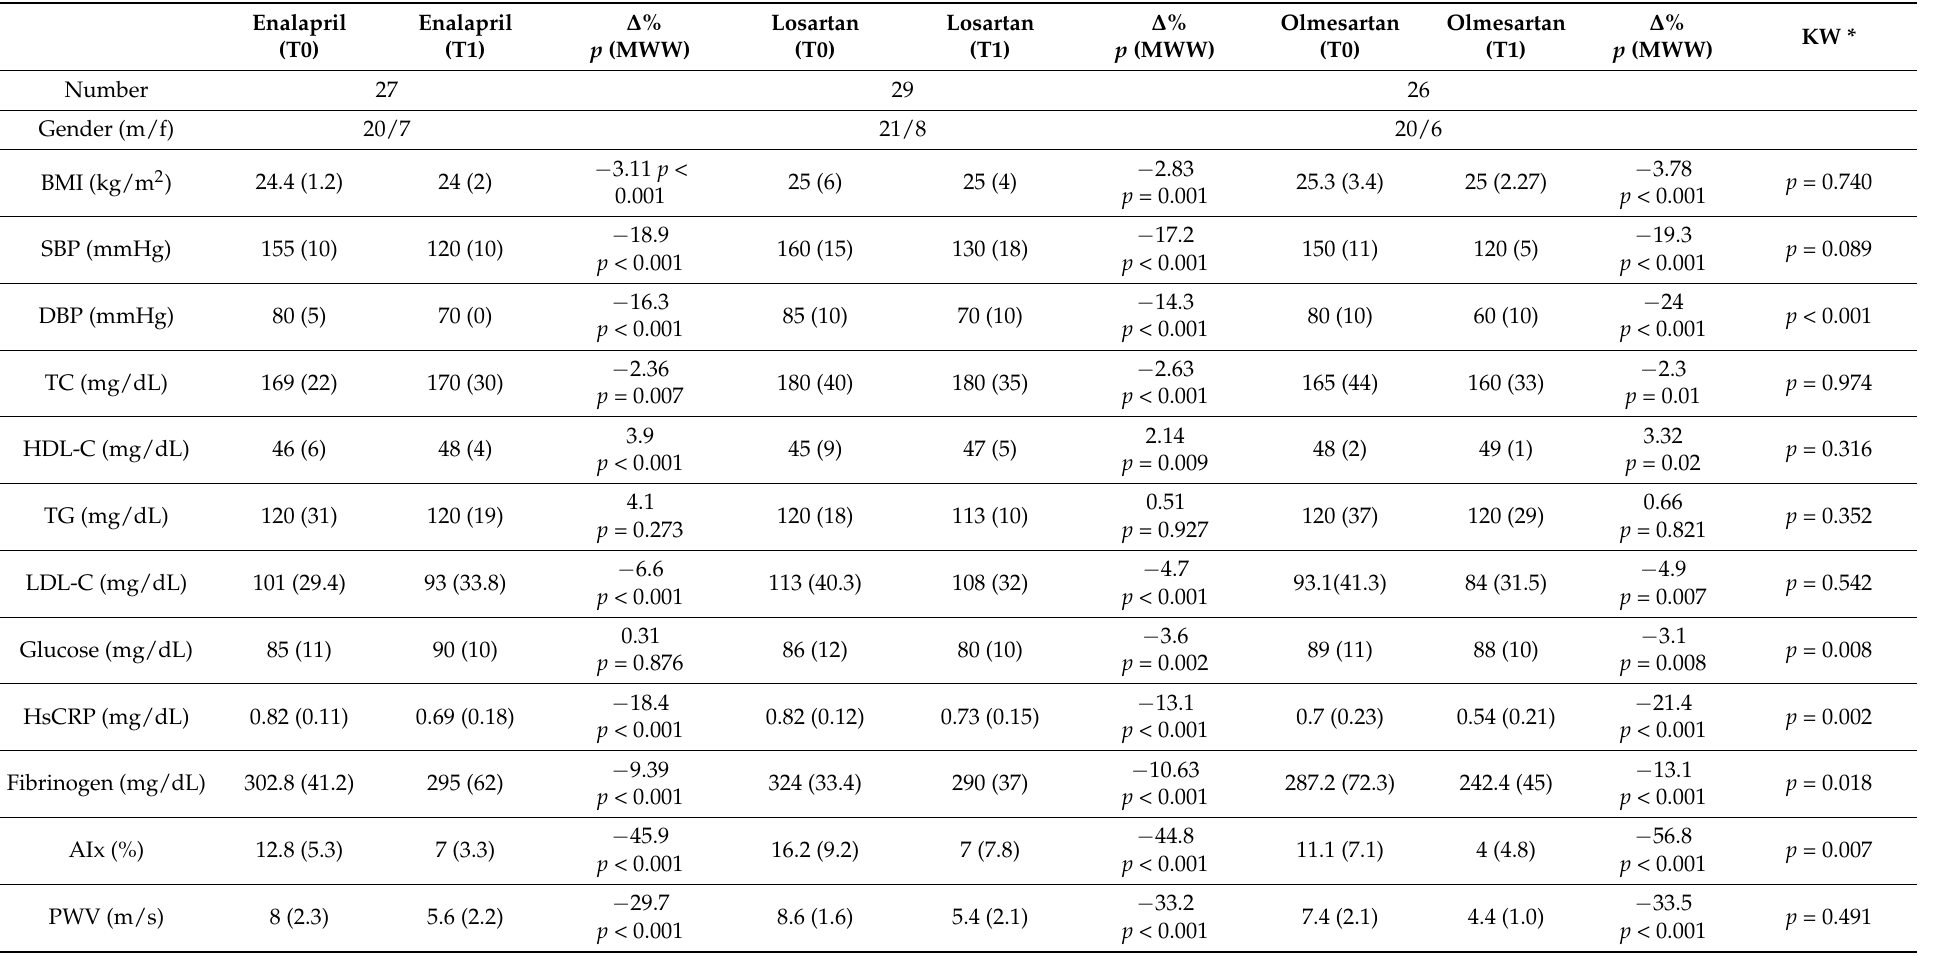
Table 3. Characteristics of hypertensive patients at baseline (T0) and after 6-month antihypertensive therapy (T1) according to the treatment